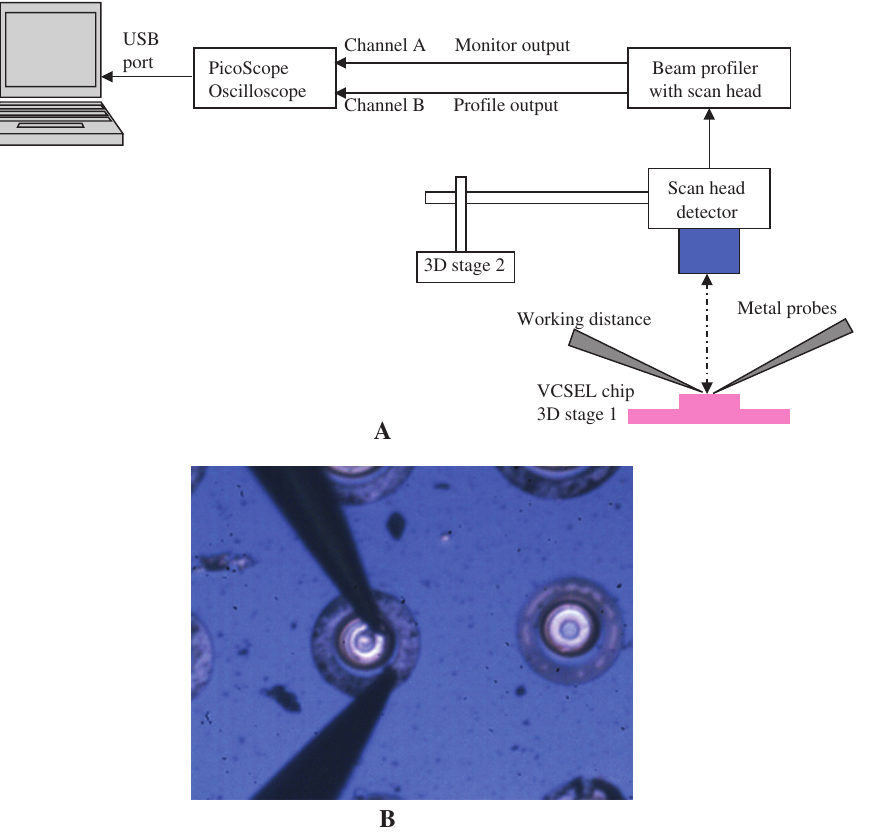
Figure 7: Experimental setup for (A) beam profile measurement of the metalensed VCSEL; (B) probing the